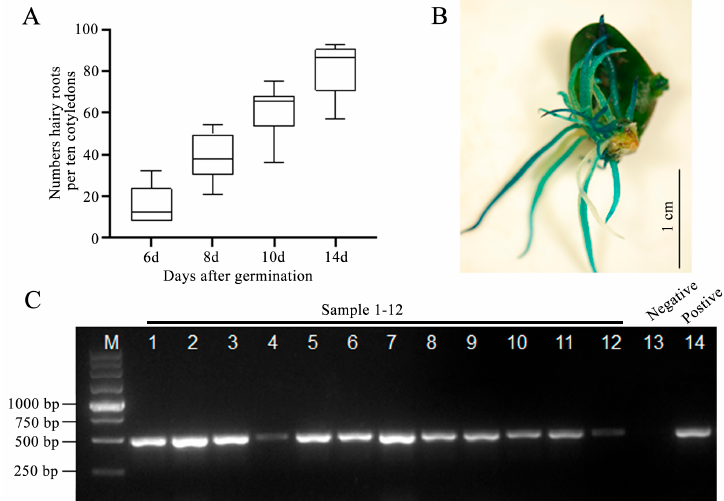
Figure 2. Generation and verification of transgenic hairy roots. ( A ) Numbers of hairy roots generated at different days post- A. rhizogenes inoculation. Hairy root numbers of each ten cotyledon were calculated. ( B ) GUS-staining assay of hairy roots at 14 days after germination. Bars = 1 cm. ( C ) PCR identification of positive hairy roots. Lane 1–12, GUS-positive roots; lane 13, negative control; lane 14, positive control, respectively.